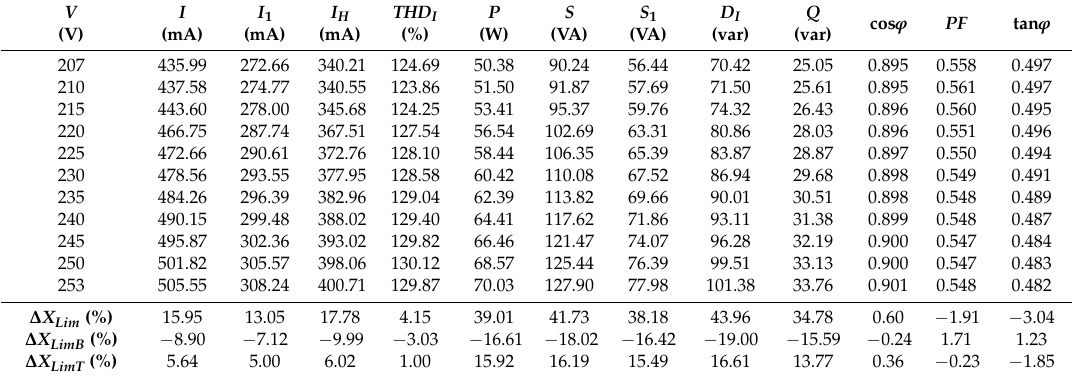
Table 3. Summary of the measured values of the electrical parameters of the lighting luminaires marked as LUM3.